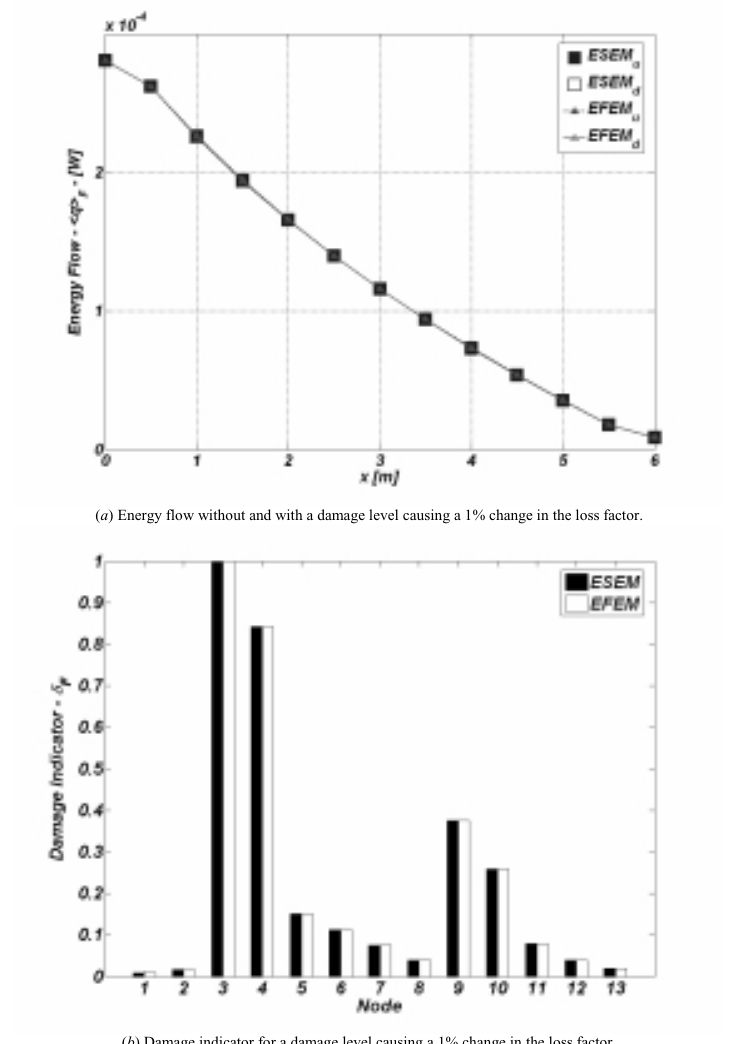
Fig. 5. Flexural energy flow and damage indicator by ESEM and